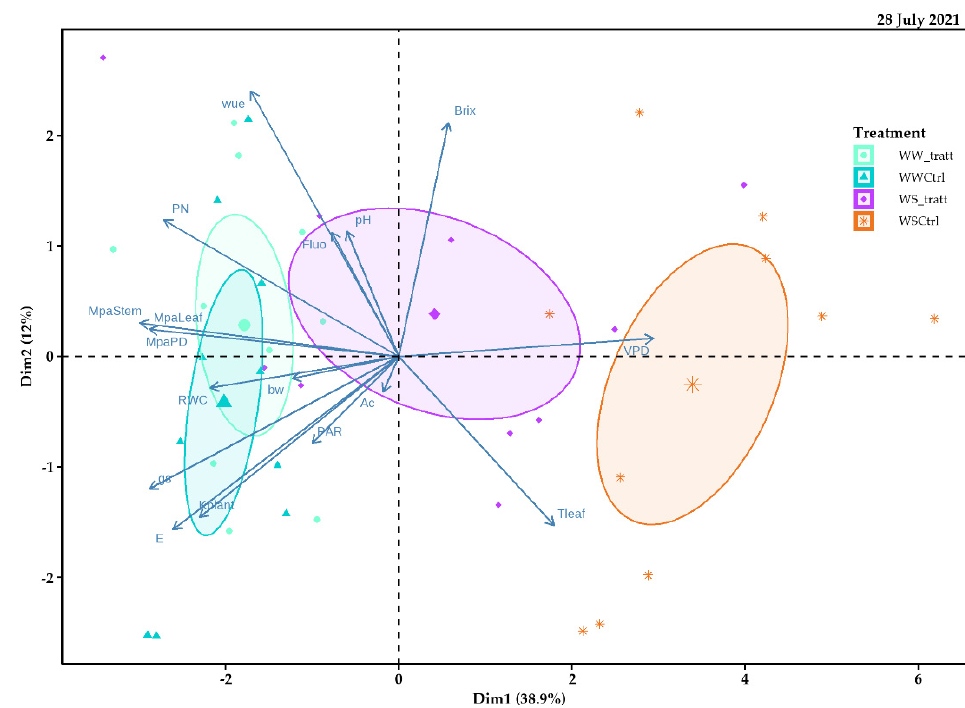
Figure 11. Relationship between principal component 1 (Dim1) and principal component 2 (Dim2) for response variables analyzed in field experiments with Pinot Noir cultivar subjected to different treatments (WWt, WWCtrl, WSt, and WSCtrl) during the 2021 season (28 July 2021). Principal component 1 (Dim1) of the 5 August 2021 explained 37.1% of the data var- iability and allowed for visualizing different treatment behaviors (delimited by different colored ellipses) in comparison, carried out based on the response variables. The WWt and WSt treatments were similarly distributed to the right of the spatial distribution. These treatments were negatively related to production variables such as sugar content (°Brix) and acidity (Ac), and positively related to water potential parameters such as MPa PD , MPaLeaf, and MPaStem. Instead, principal component 2 (Dim2) explained 19.3% of the data variability (Figure 12).